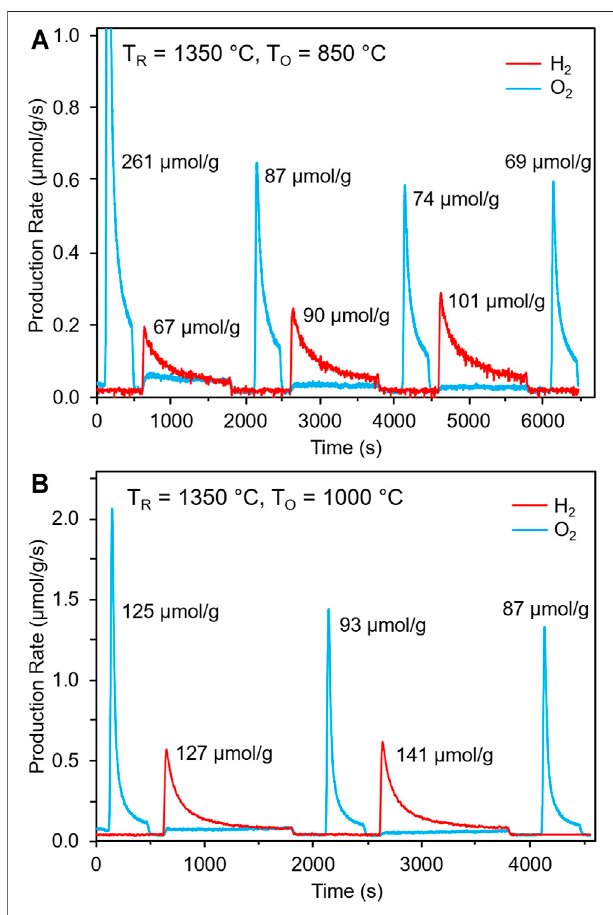
FIGURE 4 | Water splitting experiment on GLCF at T R (cid:1) 1,350 ° C (330 s) and (A) T O (cid:1) 850 ° C and (B) T O (cid:1) 1,000 ° C with 40 vol% H 2 O (1,200 s).